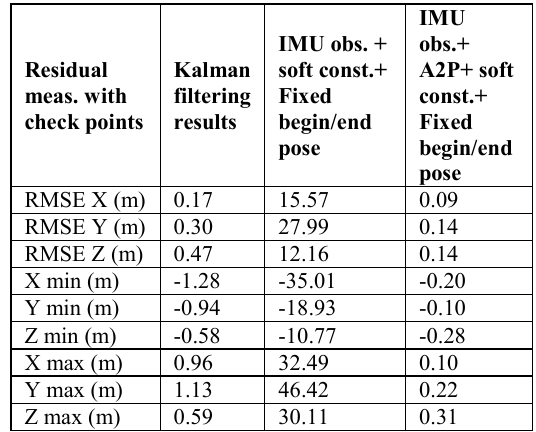
Table 2: Comparison of residuals from three different trajectories calculated with check